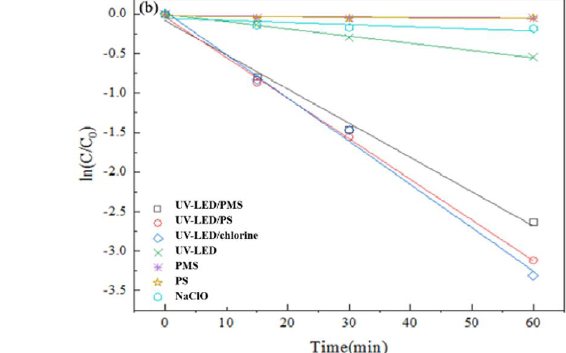
Figure 2. Degradation of CAP using UV-LED/PS, UV-LED/PMS, UV-LED/chlorine, UV-LED, PMS, PS and NaClO. ( a ) y axis is C/C 0 ; ( b ) y axis is ln(C/C 0 ). Conditions: [CAP] 0 = 5.0 mg/L, [PS] = [H 2 O 2 ] = [NaClO] = 0.5 mM, pH = 7.0, wavelength = 280 nm and lamp power I 0 = 2.4 mW/cm 2 .